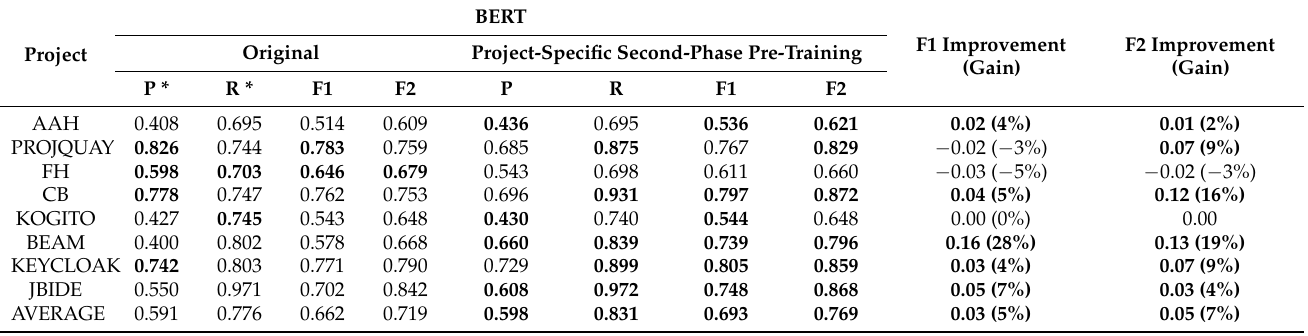
Table 6. Effect of second-phase pre-training on trace link